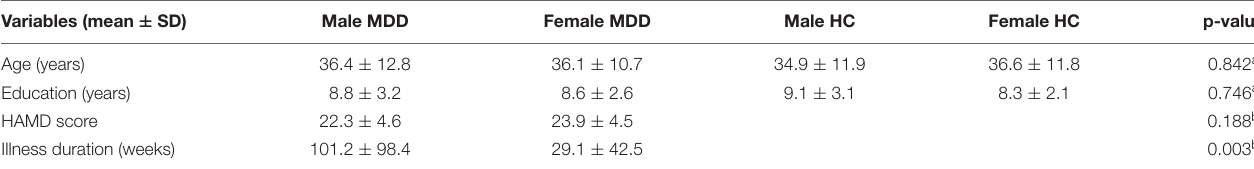
TABLE 1 | Demographic and clinical characteristics of all of the